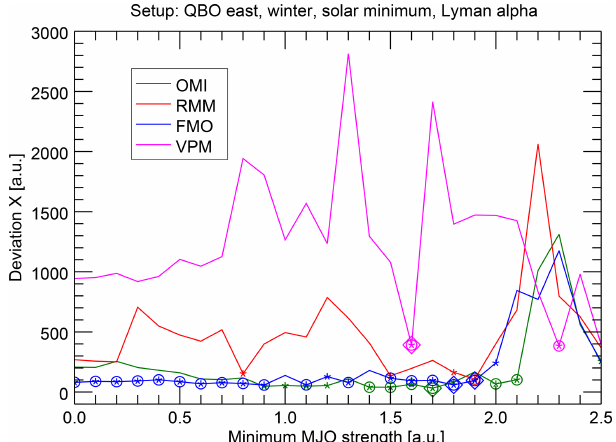
Figure 10. As in Fig. 5, but also showing the analysis results for alternative MJO indices. The green line corresponds directly to the green line in Fig.